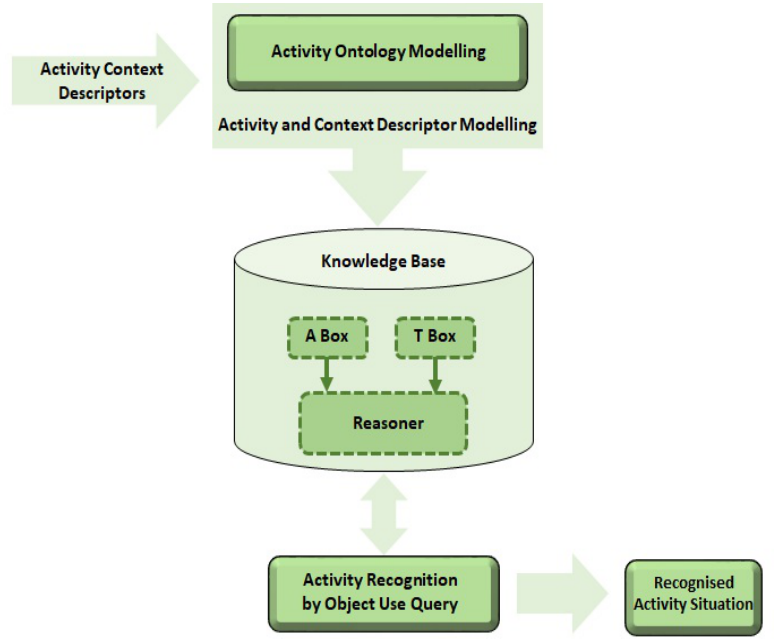
Figure 3. An overview of the activity ontology